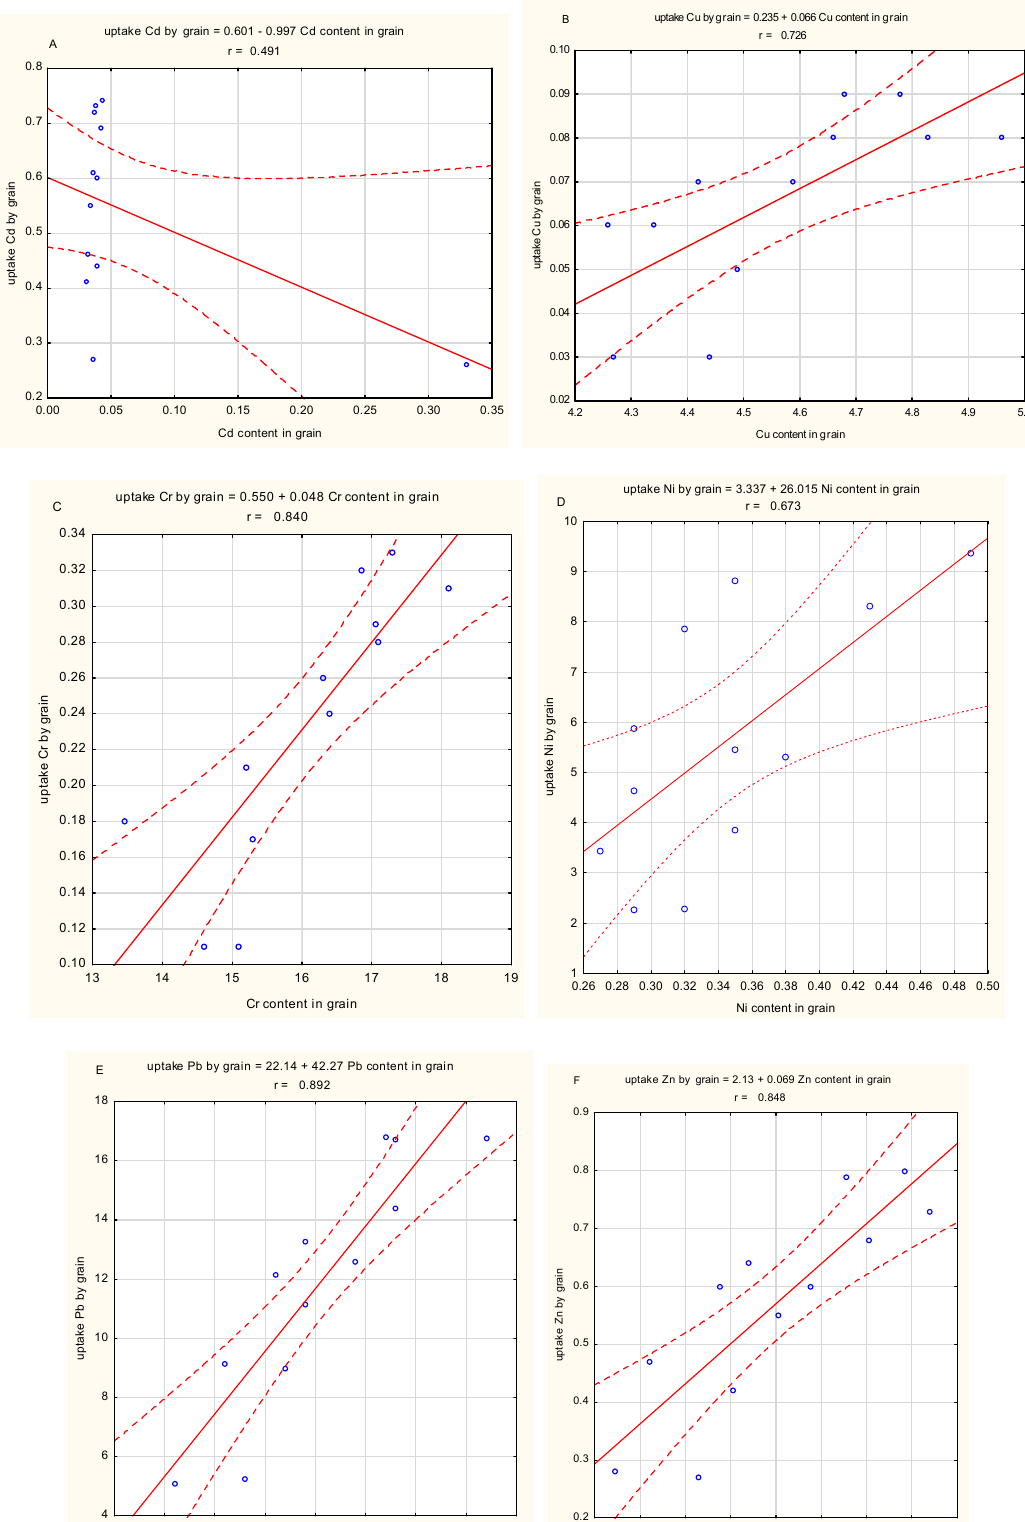
Figure 2. Rectilinear relationship between the content and uptake of heavy metals by triticale grain under the influence of applied fertilizer granulates in mg · kg − 1